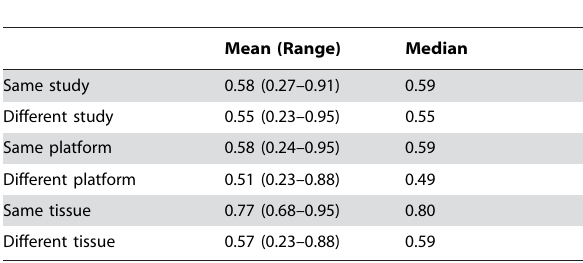
Table 4. Pairwise absolute correlation coefficients for normal non-hematopoietic cell